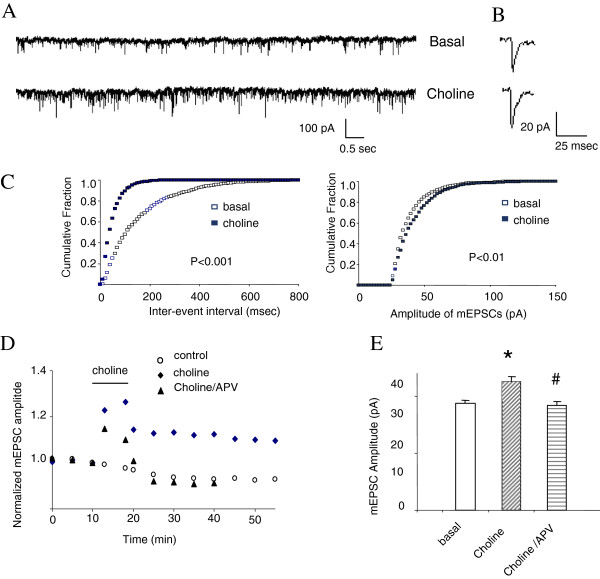
Choline induced upregulation of NMDAR-dependent LTP of mEPSCs in cultured hippocampal neurons. (A) Examples of continuous recordings from individual neurons 5 minutes before (Basal) and 30 minutes after 8-minute stimulation of neurons with 1 mM choline. (B) Single events taken from the basal and choline traces, respectively showing that the amplitude of mEPSCs was increased by choline application. (C) Cumulative fraction plots for mEPSCs inter-event intervals and amplitudes obtained 5 minutes before (Basal) and 30 minutes after choline (8 min, 1 mM). (D) mEPSC amplitudes are normalized to the values from the initial 10 min and plotted over time. Treatment of neurons with choline (8 min, 1 mM) significantly increased the amplitude of the mEPSCs over the time course of recordings; an effect can be abolished by NMDAR antagonist, AP5 (100 μM). (E) Amplitude histogram summarizes data from groups of individual neurons treated with glycine (200 μM; 3 min) in the absence or presence of choline (1 mM) or choline/AP5 (100 μM). Responses obtained 30 min after glycine treatment (26.5+/- 2.3 pA), 30 min after choline treatment (31.4 +/-2.7 pA, n = 6, *p < 0.01) and 30 minutes after coapplication of choline/APV (25.9+/-2.0pA n = 3, **p < 0.05, paired t-test).